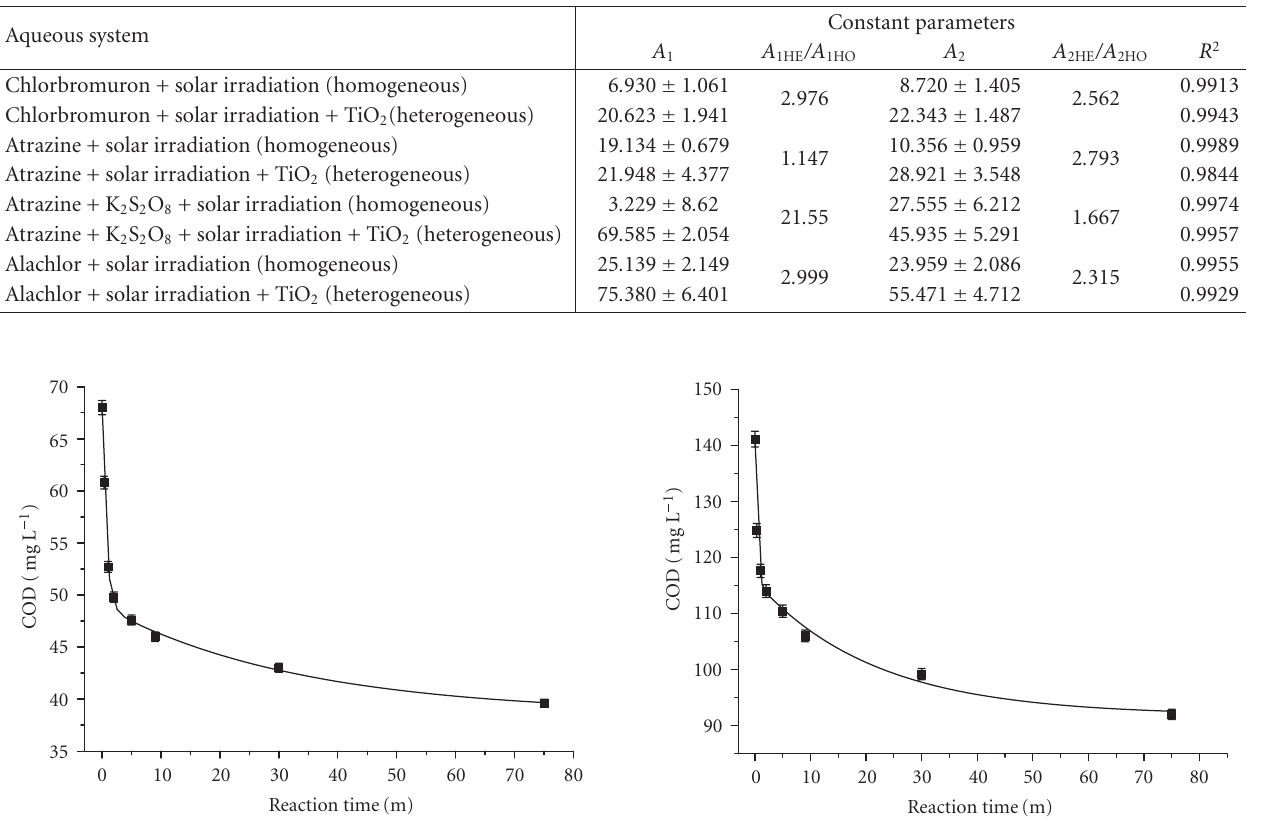
Table 1: Showing the values for the constant parameters obtained from the best fit of the experimental COD data to an exponential decay second-order equation. A 1HE /A 1HO is th ratio: A 1 from heterogeneous systems to A 1 from the homogeneous systems. A 2HE /A 2HO is the ratio: A A 2 from heterogeneous systems to 2 from the homogeneous systems.